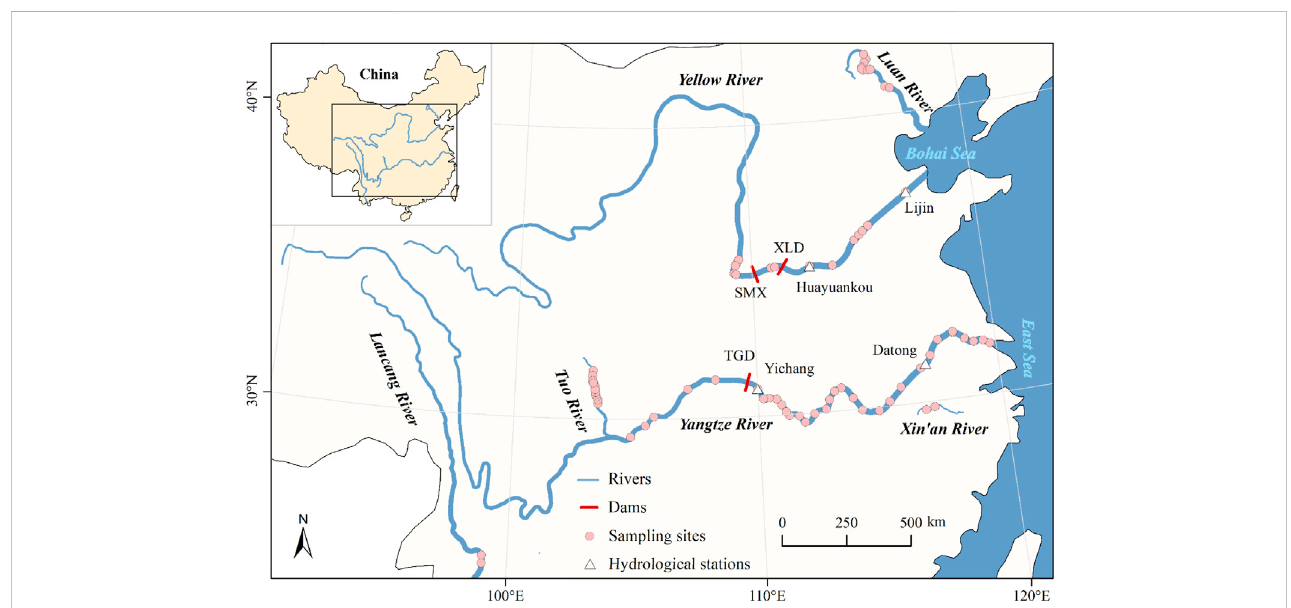
FIGURE 1 ThesamplingsitesalongsixdifferentriversinChinaandtherelevantlocationsusedinthisstudy.TGD,SMX,andXLDrespectivelydenotethedamsforthe Three Gorges, Sanmenxia, and Xiaolangdi reservoirs.